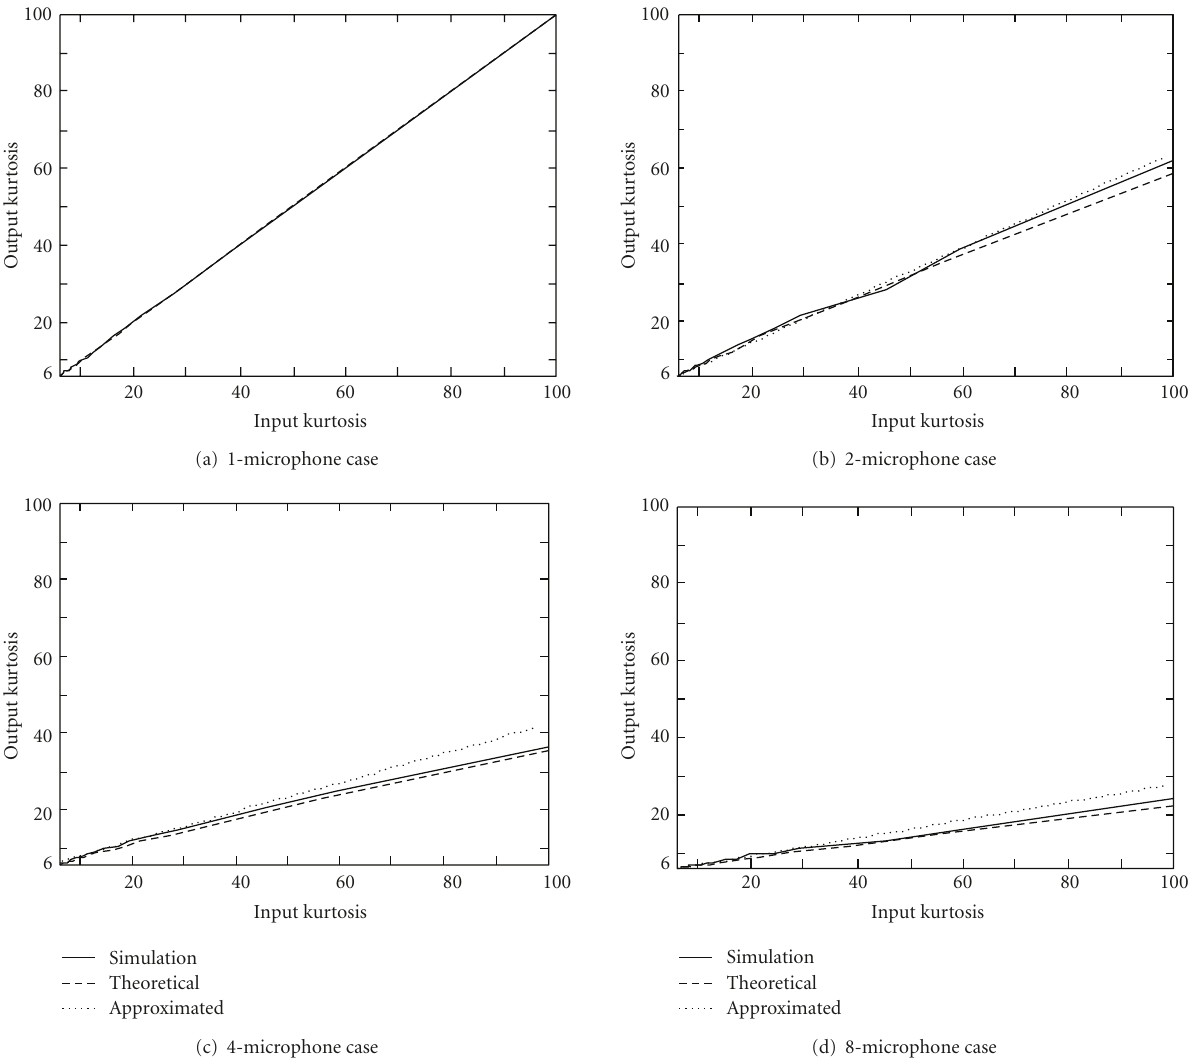
Figure 7: Relation between input kurtosis and output kurtosis after DS. Solid lines indicate simulation results, broken lines express theoretical plots obtained by (22), and dotted lines show approximate results obtained by